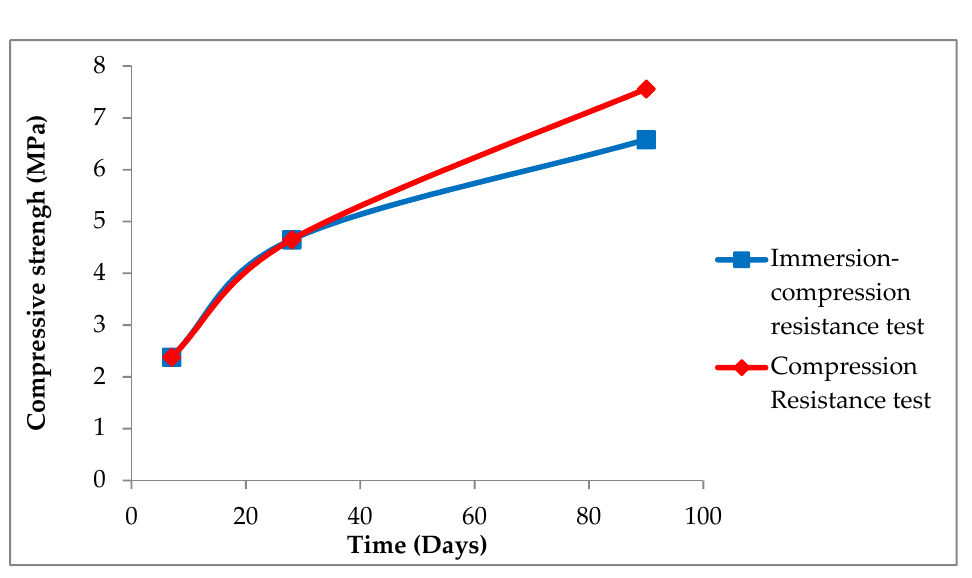
Figure 9. Comparison of compressive strength and compression-immersion graph results.